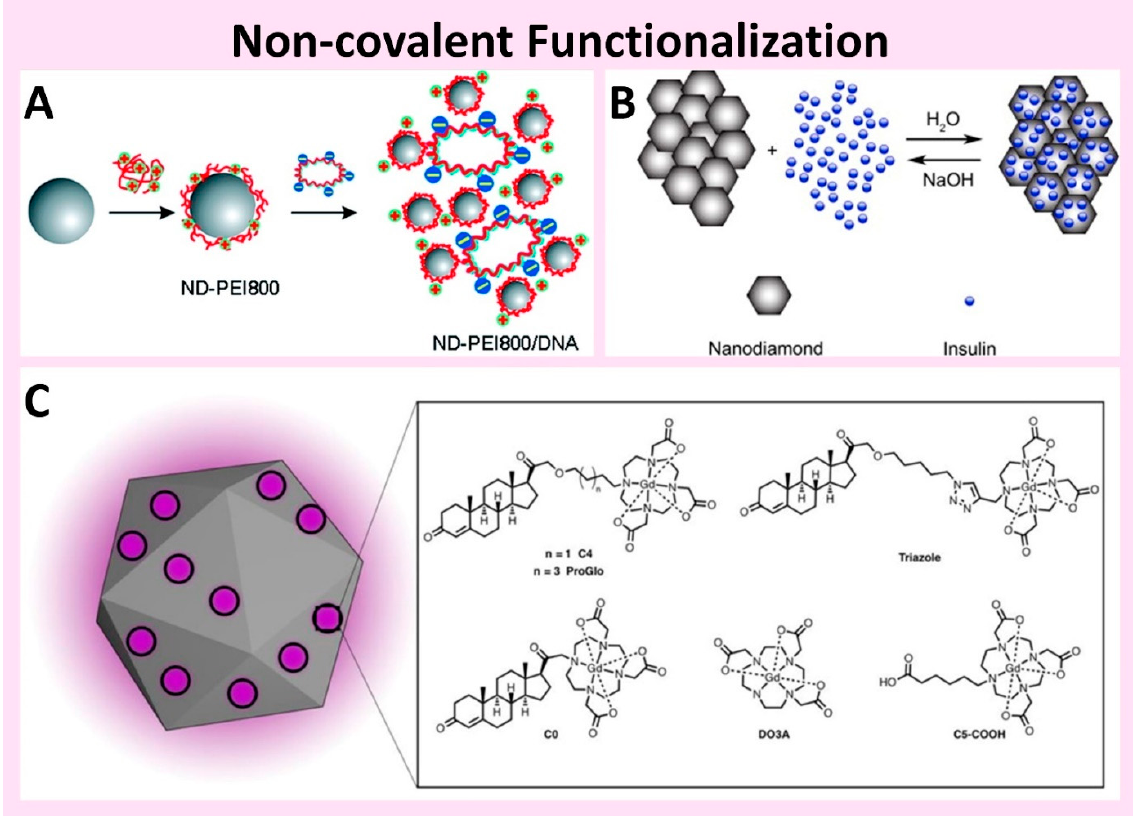
Figure 2. Non-covalent physical adsorption functionalization approaches: ( A ) Positively charged 800 Da polyethyleneimine is immobilized on the negative charged ND surface via electrostatic interactions. Reproduced from [78], with permission from American Chemical Society, 2009; ( B ) Hormone insulin adsorbed onto the ND surface through electrostatic interactions and H-bonding is used as drug delivery vehicle. Reproduced from [79], with permission from Elsevier, 2009; ( C ) To increase the aqueous solubility of the steroid receptor-targeted magnetic resonance imaging contrast agent ProGlo (purple circles), it was physically adsorbed to the ND surface. Due to the increased solubility, the resulting ND-ProGlo particles were efficiently accumulated in T47D breast cancer cells expressing progesterone receptors. Reproduced from [80], with permission from American Chemical Society,